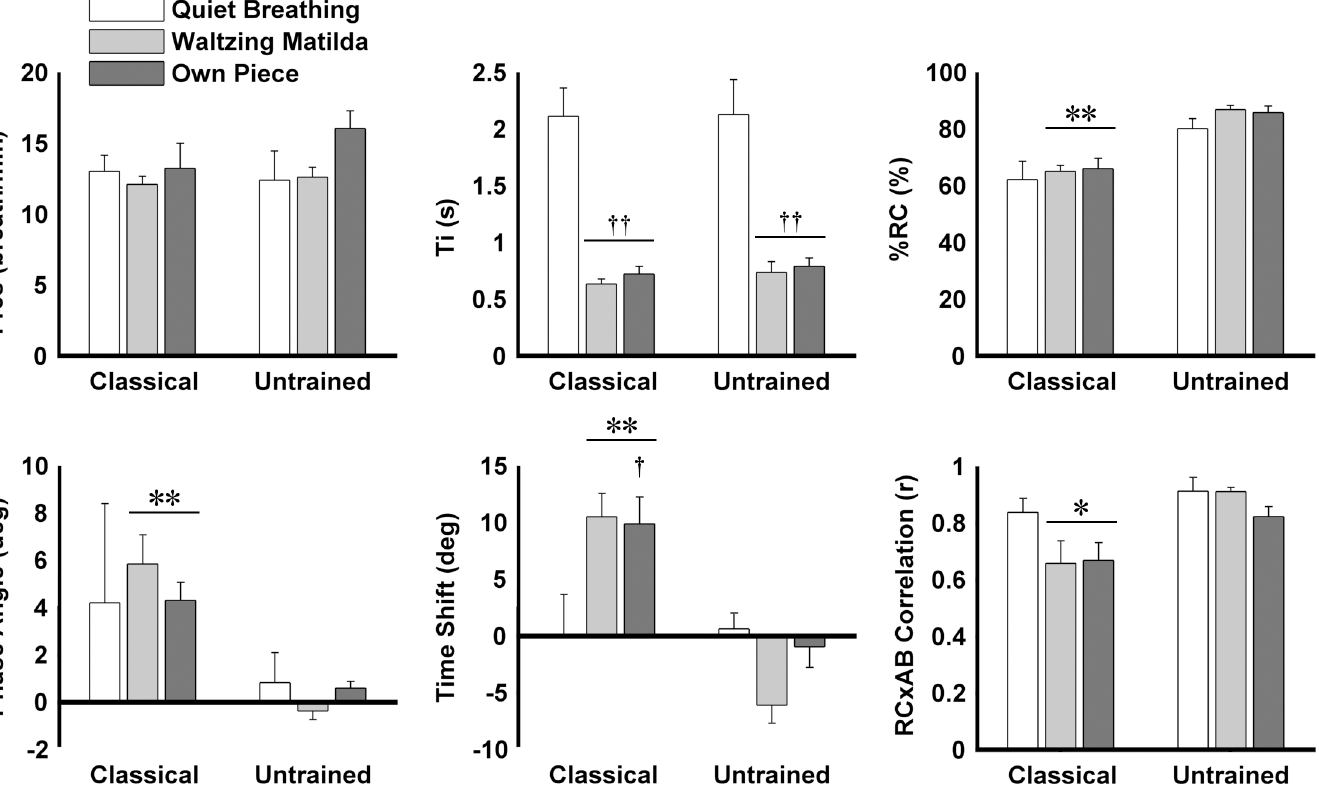
Fig 4. Respiratory frequency (Fres), time of inspiration (Ti), percentage contribution of rib cage to total lung volume (%RC), phase angle, time shift, and linear correlation coefficient between rib cage (RC) and abdomen (AB) volume waveforms of classical singers and untrained individuals during each of the three tasks assessed. Mean + SEM are shown. * P < 0.05, ** P < 0.001 vs. untrained individuals. † P < 0.05, †† P < 0.001 vs. quiet